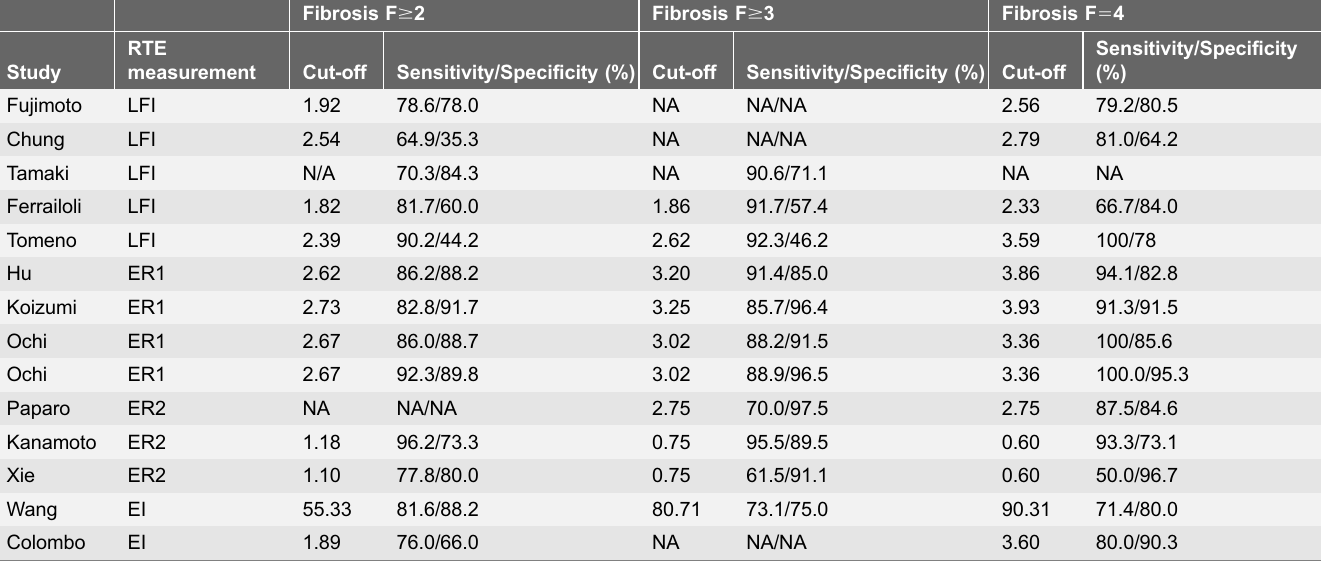
Table 2. Diagnostic indices of studies evaluating the performance of RTE for staging liver